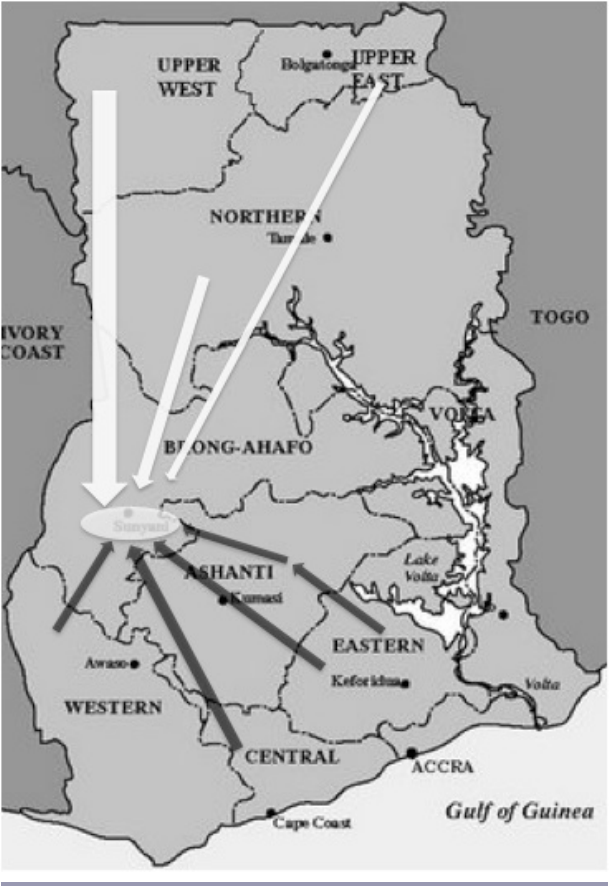
Fig. 1. Generalized migration patterns within Ghana to the study area, Sunyani District, Brong Ahafo Region. Light arrows indicate migration from northern regions (Upper West, Upper East, and Northern) to the study region based on interviews; the size of the arrow indicates the magnitude of migration, with higher levels of migration from the Upper West based on van der Geest (2011). Darker arrows indicate settler farmers from neighboring regions (Eastern, Central, and Western) in southern Ghana based on a selection of interviews with farmers in the Sunyani